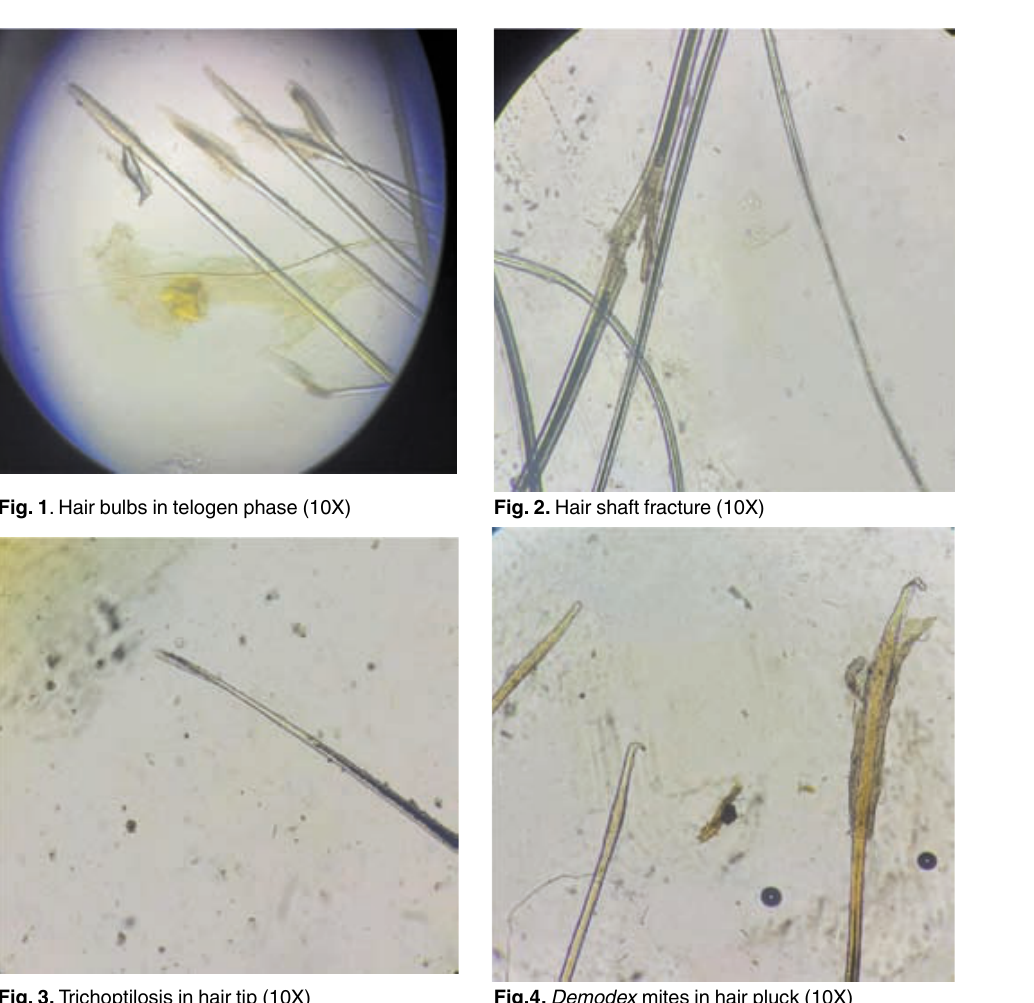
Fig.4. Demodex mites in hair pluck (10X) Fig. 3. Trichoptilosis in hair tip (10X)